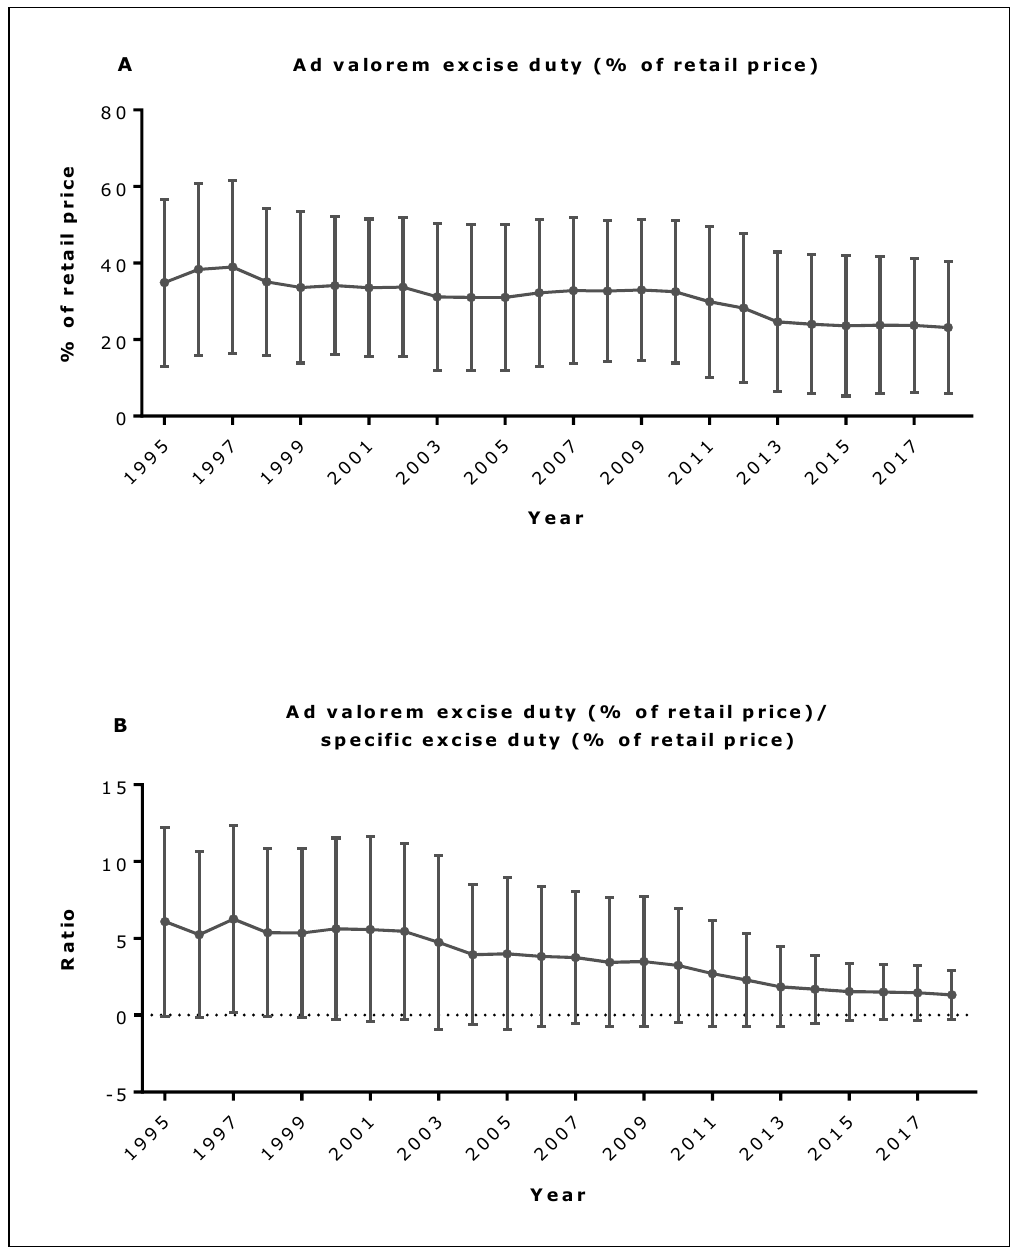
Error bars represent standard deviation. Figure 2. ( A ) Mean EU ad valorem excise duty as percentage of retail price and ( B ) mean EU ad valorem to specific excise duty ratio.